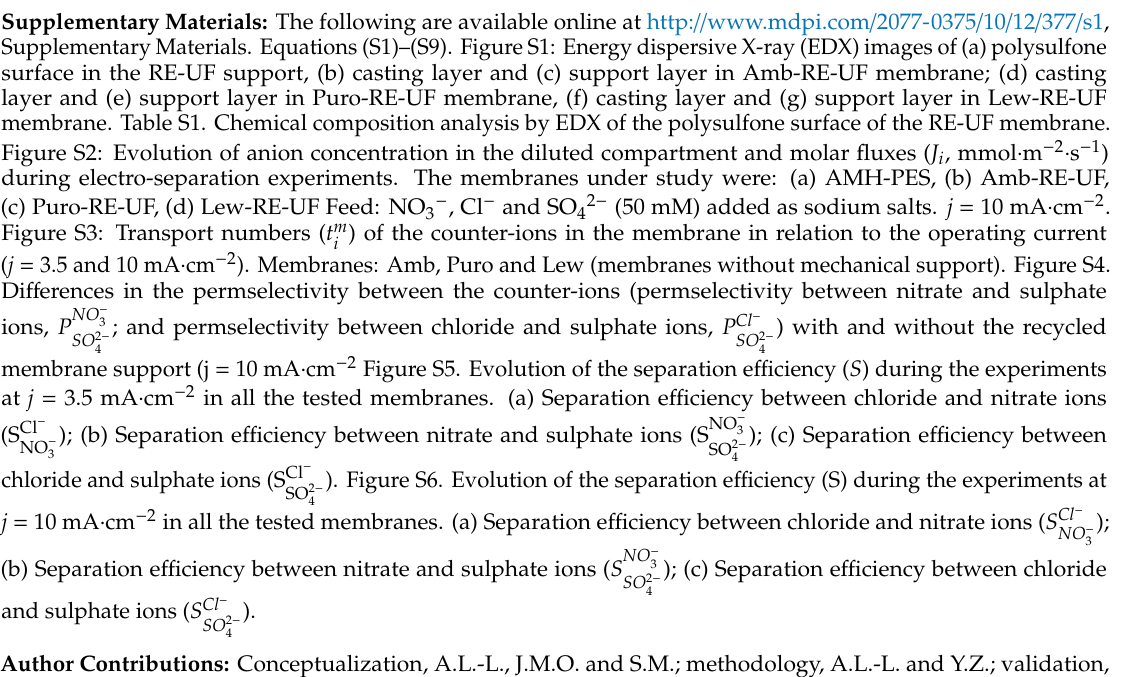
Figure S2: Evolution of anion concentration in the diluted compartment and molar fluxes ( J i , mmol · m − 2 · s − 1 ) during electro-separation experiments. The membranes under study were: (a) AMH-PES, (b) Amb-RE-UF, (c) Puro-RE-UF, (d) Lew-RE-UF Feed: NO 3 − , Cl − and SO 42 − (50 mM) added as sodium salts. j = 10 mA · cm − 2 . Figure S3: Transport numbers ( t m ) of the counter-ions in the membrane in relation to the operating current i ( j = 3.5 and 10 mA · cm − 2 ). Membranes: Amb, Puro and Lew (membranes without mechanical support). Figure S4. Di ff erences in the permselectivity between the counter-ions (permselectivity between nitrate and sulphate NO − − 3 ions, P ; and permselectivity between chloride and sulphate ions, P Cl ) with and without the recycled SO 2 − SO 2 − 4 4 membrane support (j = 10 mA · cm − 2 Figure S5. Evolution of the separation e ffi ciency ( S ) during the experiments at j = 3.5 mA · cm − 2 in all the tested membranes. (a) Separation e ffi ciency between chloride and nitrate ions − − 3 (S Cl ); (b) Separation e ffi ciency between nitrate and sulphate ions (S NO ); (c) Separation e ffi ciency between NO − 3 SO 2 − 4 − chloride and sulphate ions (S Cl ). Figure S6. Evolution of the separation e ffi ciency (S) during the experiments at SO 2 − 4 − j = 10 mA · cm − 2 in all the tested membranes. (a) Separation e ffi ciency between chloride and nitrate ions ( S Cl ); NO − 3 NO − 3 (b) Separation e ffi ciency between nitrate and sulphate ions ( S ); (c) Separation e ffi ciency between chloride SO 2 − 4 − and sulphate ions ( S Cl SO 2 − 4